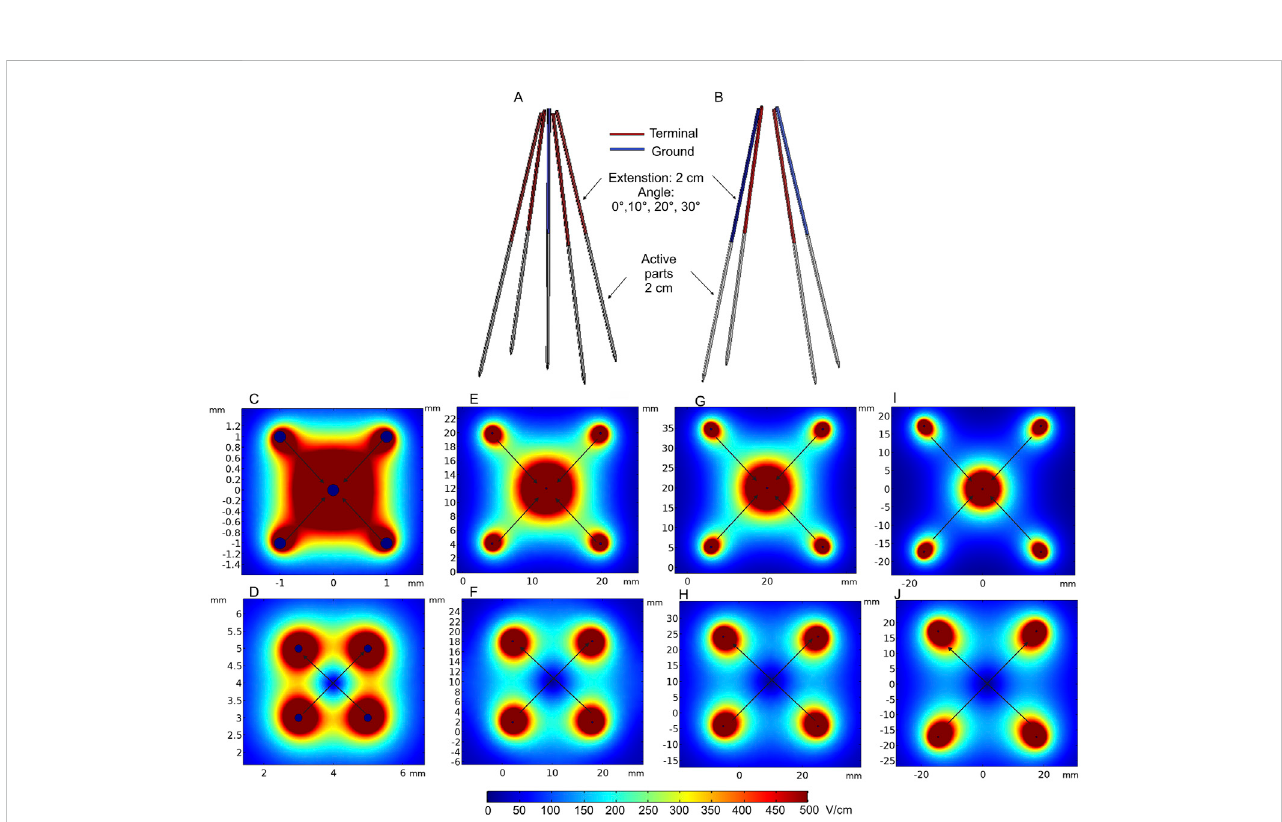
FIGURE 5 Deployable expandable electrodes: (A) 5-needle electrode structure; (B) 4-needle electrode structure with 2 cm extension; (C) spatial electric fi eld distributionofthe5-needleelectrode whenpositionedat0 ° angle; (D) spatial electric fi elddistributionofthe4-needleelectrodewhenpositionedat0 ° angle; (E) spatialelectric fi elddistributionofthe5-needleelectrodewhenpositionedat10 ° angle; (F) spatialelectric fi elddistributionofthe4-needleelectrodewhen positionedat10 ° angle; (G) spatialelectric fi elddistributionofthe5-needleelectrodewhenpositionedat20 ° angle; (H) spatialelectric fi elddistributionof the 4-needle electrode when positioned at 20 ° angle; (I) spatial electric fi eld distribution of the 5-needle electrode when positioned at 30 ° angle; (J) spatial electric fi elddistributionofthe4-needleelectrodewhenpositionedat30 ° angle.* Simulationperformedincludes singlediagonal andsemi-diagonalterminal voltages (0 ° — 120 V, 10 ° — 1100 V, and 20 ° and 30 ° — 1700 V)